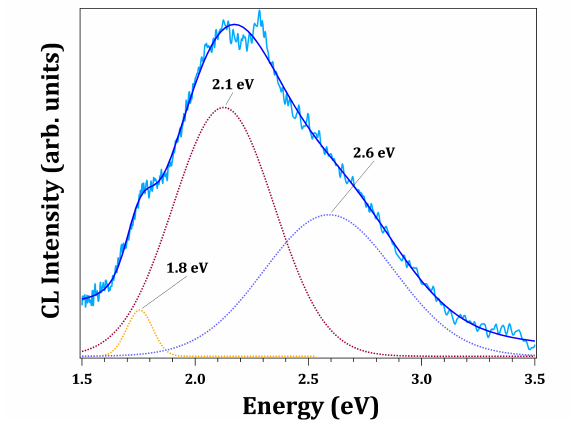
Figure 7. CL spectrum (light blue line) of WO nanostructures deposited on the copper electrodes. 3 Data were deconvoluted into three Gaussian components (dotted lines). Fitted data (dark blue